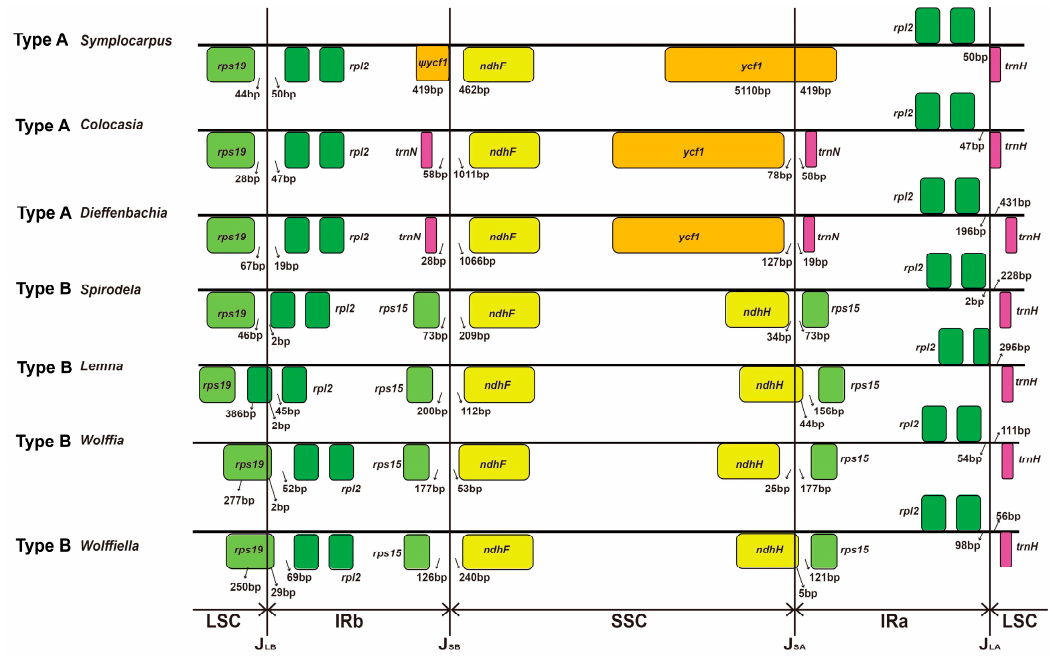
Figure 6. Comparison of LSC, SSC and IR junction positions among Araceae species.